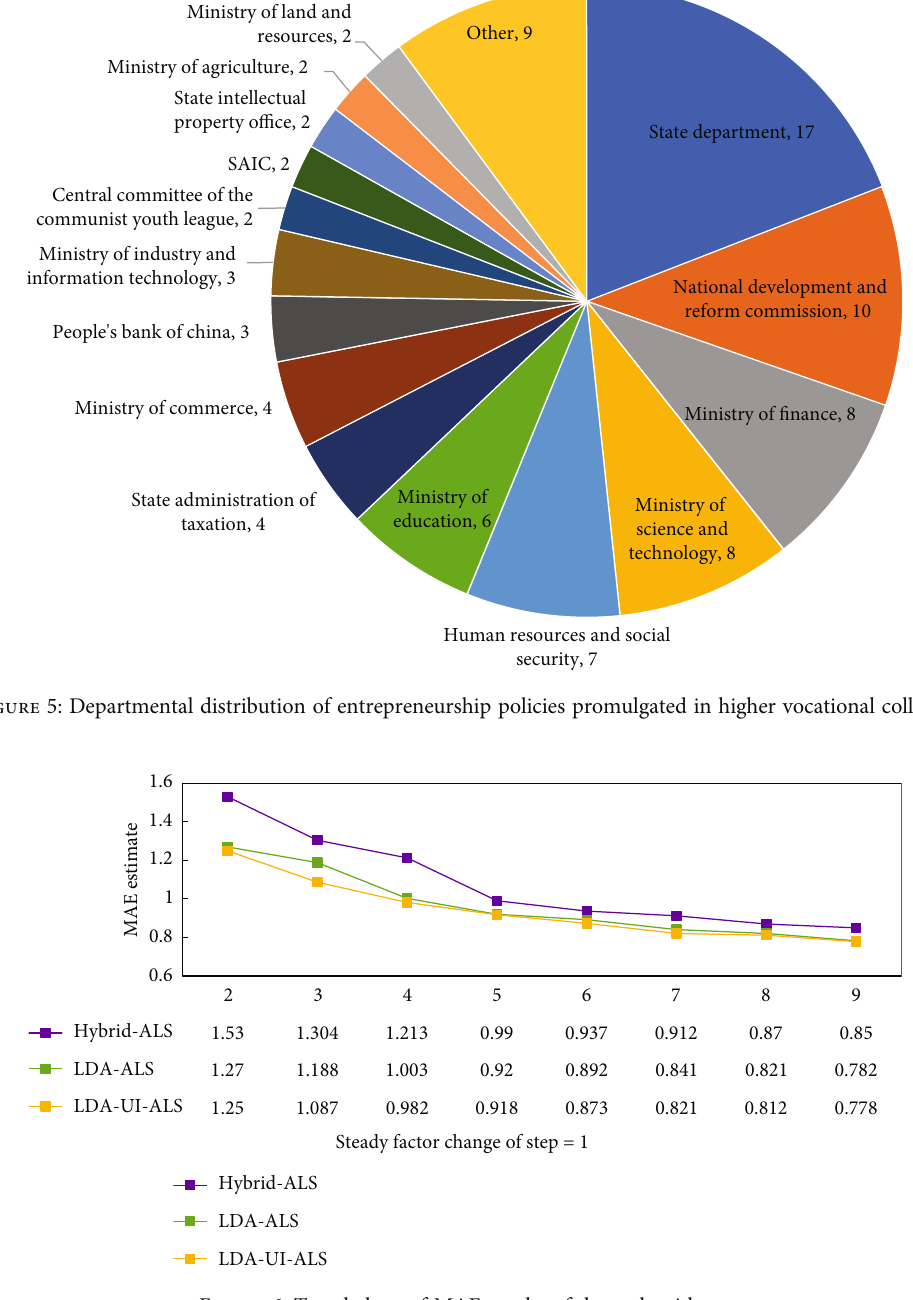
Figure 6: Trend chart of MAE results of three